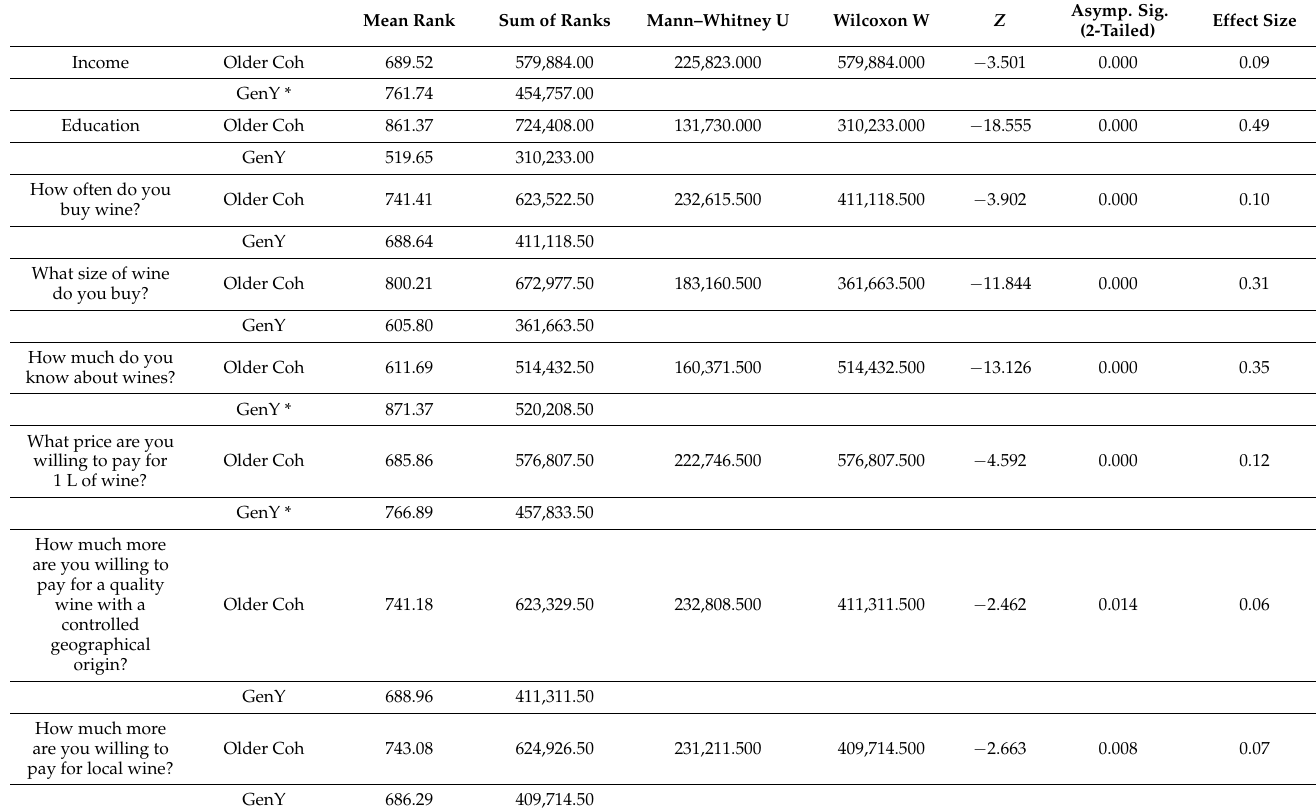
Table 3. Mann–Whitney test statistics (grouping variable: